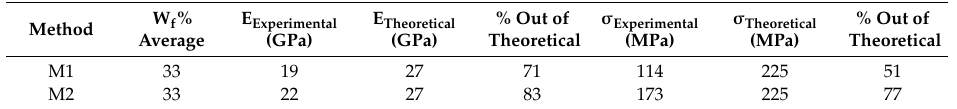
Table 3. Normalized average tensile properties for each method based on unified, normalized, fiber weight fraction of 33%.